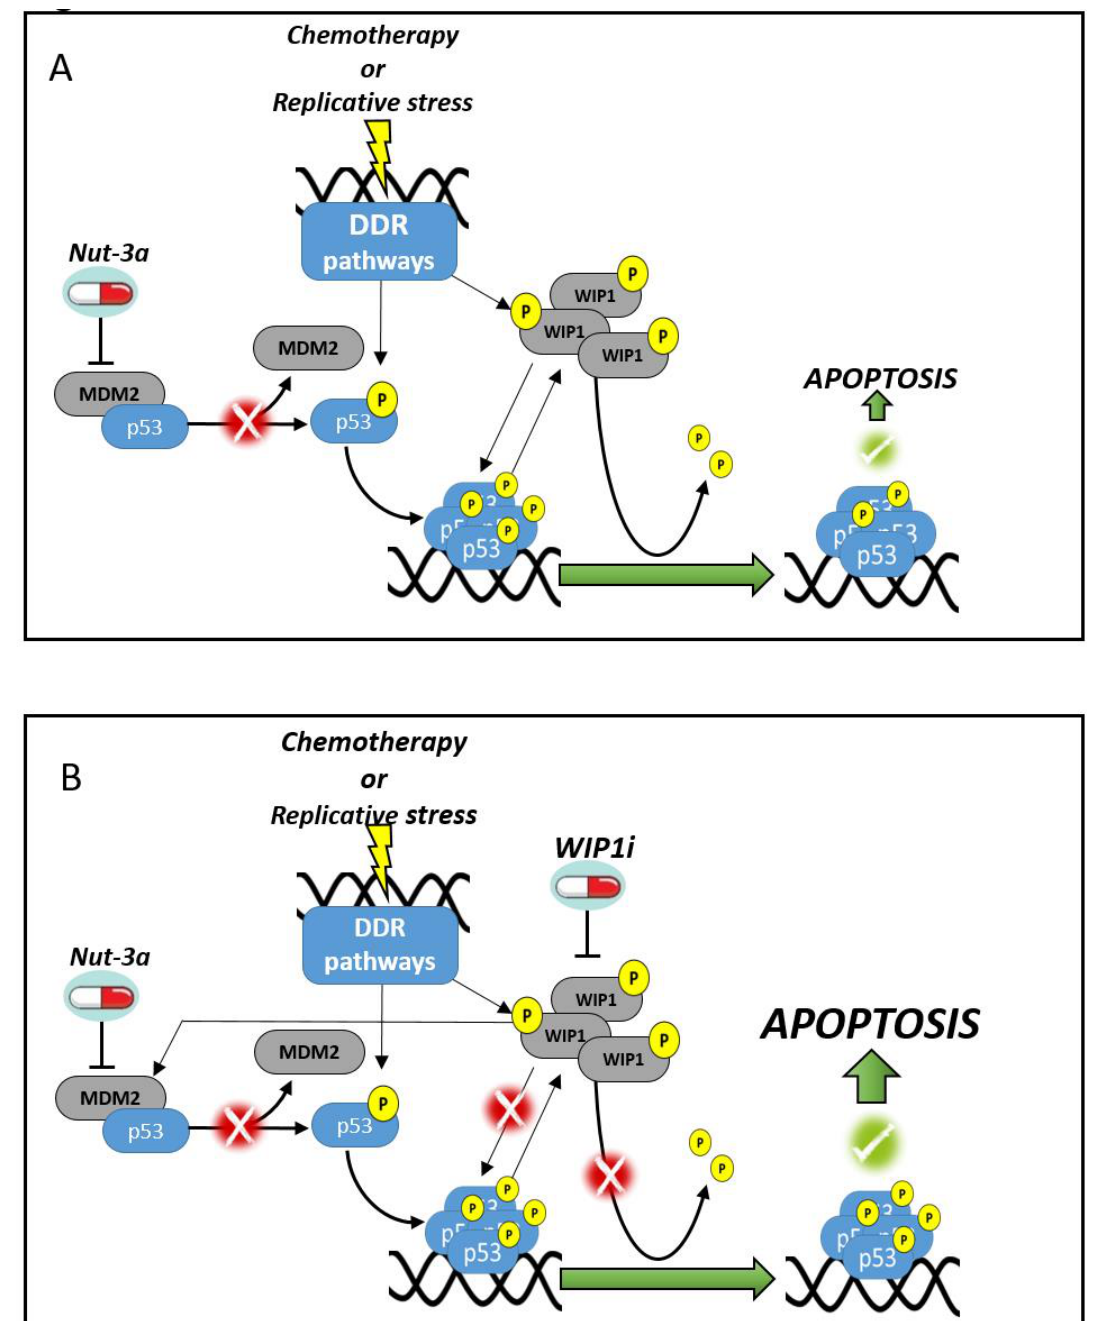
Figure 6. Proposed mechanism of action of Nut-3a and WIP1i combined treatment in AML cells. MDM2 inhibition enhances p53-dependent response to DNA damages induced by chemotherapy agents or replicative stress. Once Nut-3a binds to MDM2, p53 is released and activated through phosphorylation. Active p53 promotes the induction of apoptosis. ( A ) WIP1 is involved in the regulation of response to Nut-3a and dephosphorylates p53. WIP1 and p53 are co-regulated by a feedback-loop. ( B ) When WIP1i is simultaneously added to Nut-3a, p53 activation is enforced, resulting in enhanced apoptosis of AML cells. The arrows represent a stimulatory signal, truncated arrows represent a inhibition signal. Supplementary Materials: The following are available online at https://www.mdpi.com/article/10 .3390/biomedicines9040388/s1, Table S1: Combination index analysis of TP53 -wt AML cells, Table S2: Characteristics of primary AML samples, Table S3: Top 20 upregulated (red) and downregulated (blue) genes in MV-4-11 cells treated with Nut-3a+WIP1i vs. control, Table S4: Top 20